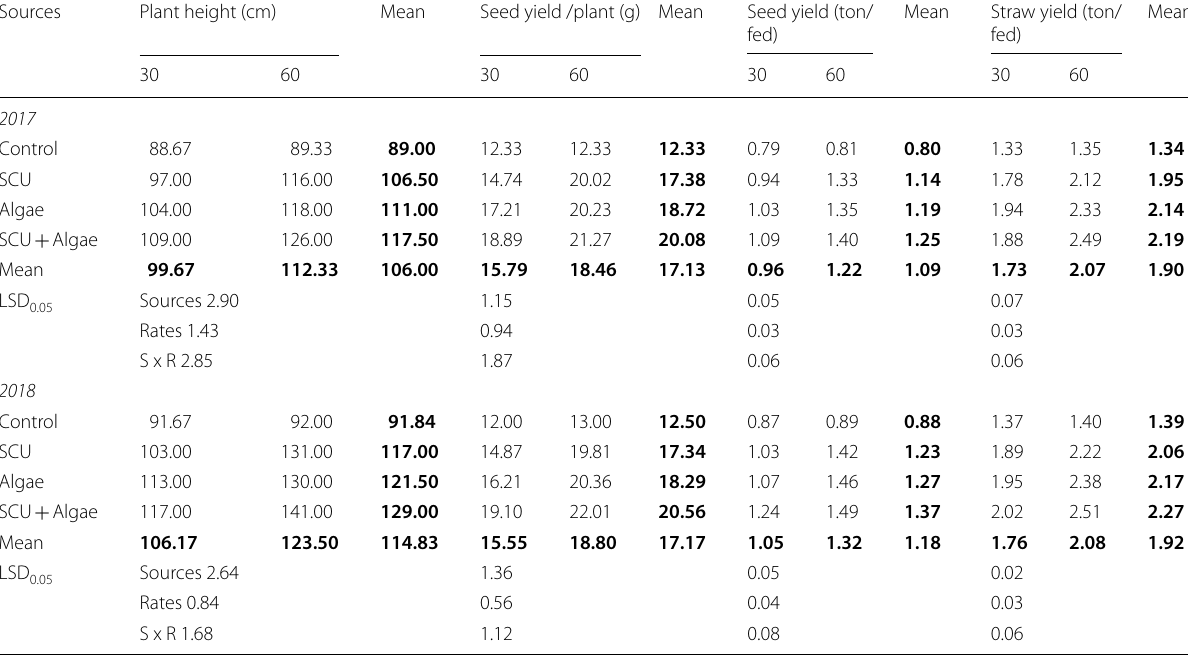
S x R Sources x Rates =